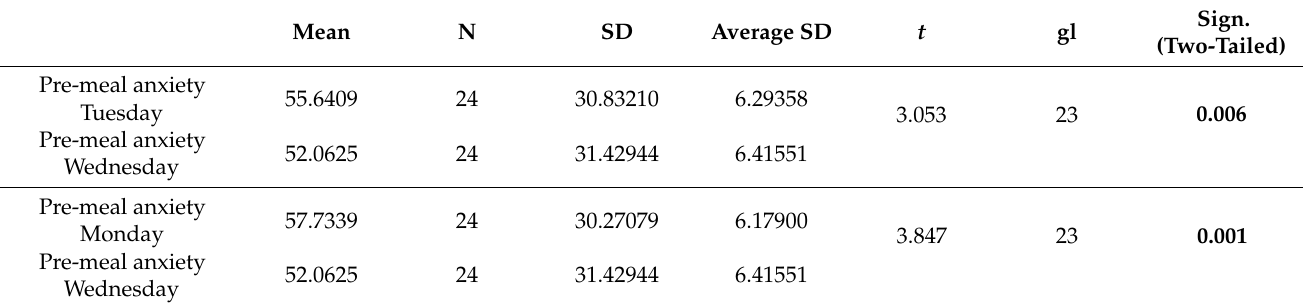
Table 2. Results of t -test, significance: p <